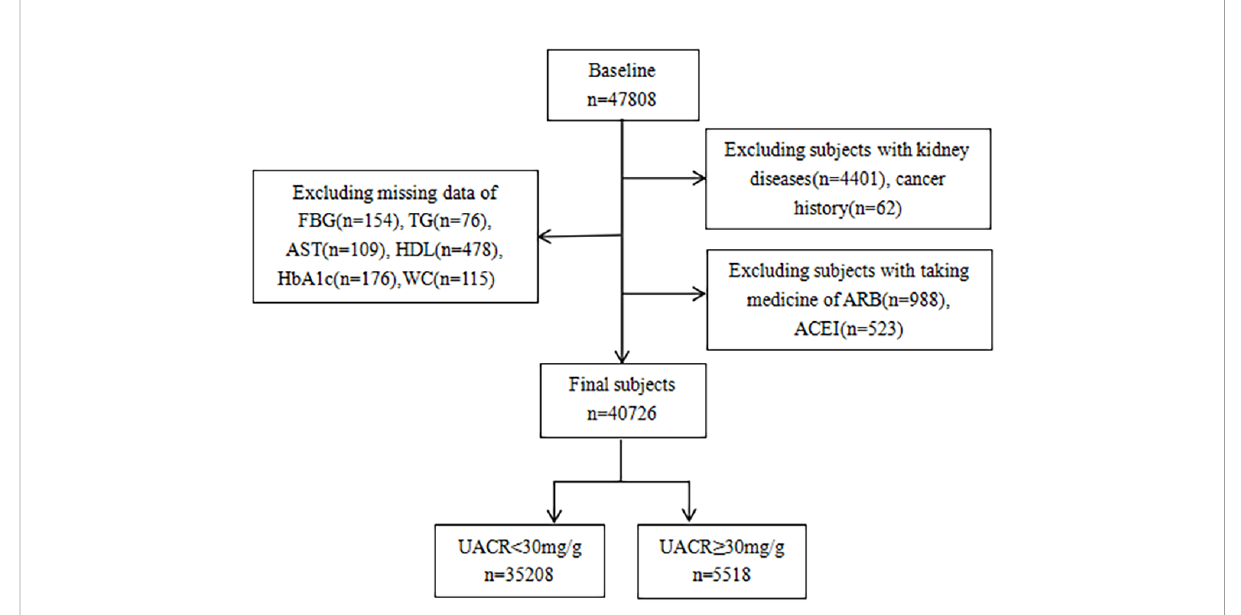
FIGURE 1 Flowchart of the study